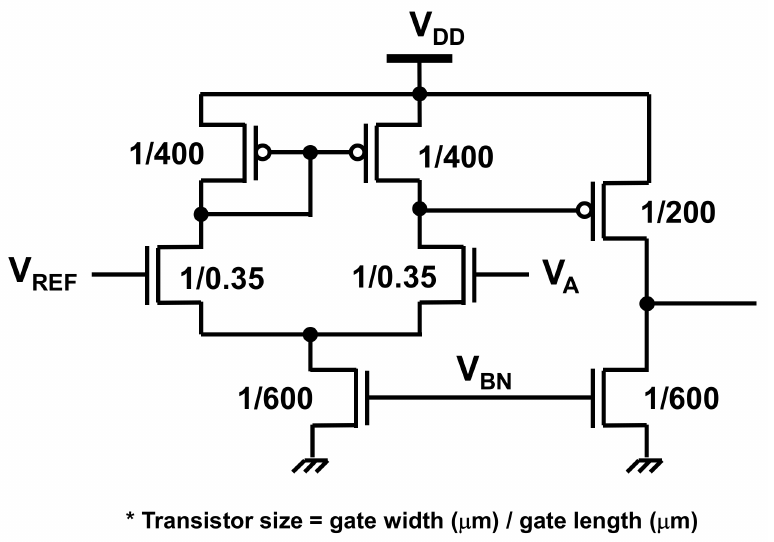
Figure 7. Circuit schematic of the comparator used to detect hand motion. V A is the amplified signal induced by the hand movement, as illustrated in Figure